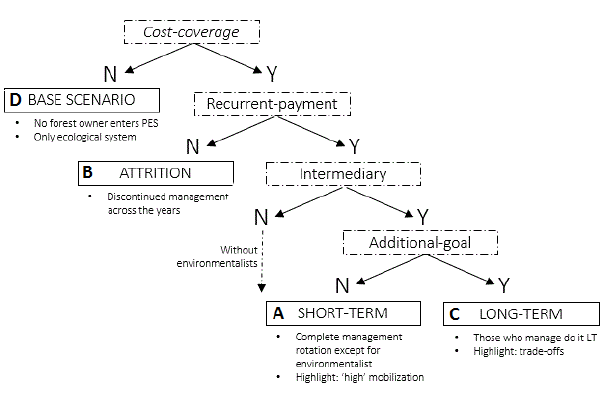
Fig. 2 . Interactions between agent behavior and policy design: opted for